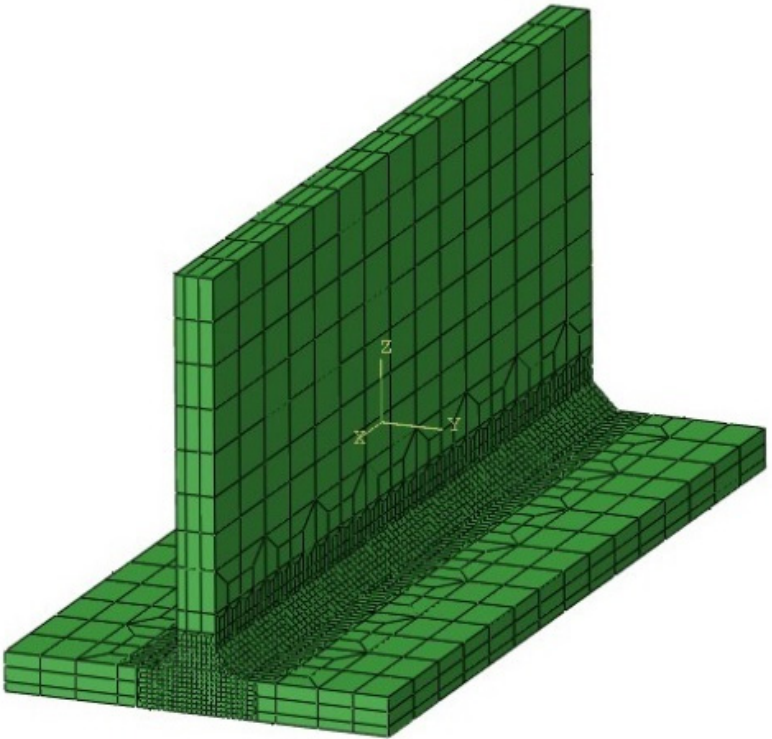
Figure 2. Finite element mesh of the T-joint specimen.